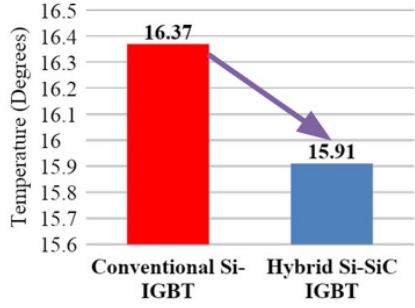
Figure 13. Mean T j Comparison.